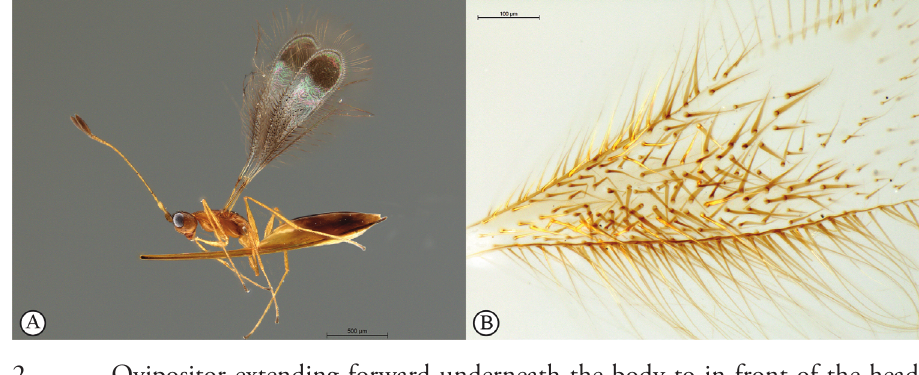
2 Ovipositor extending forward underneath the body to in front of the head (A); modified fore wing disc microtrichia numerous and shorter (B) ............. ........................................................................................ P. sagittaria sp. n.